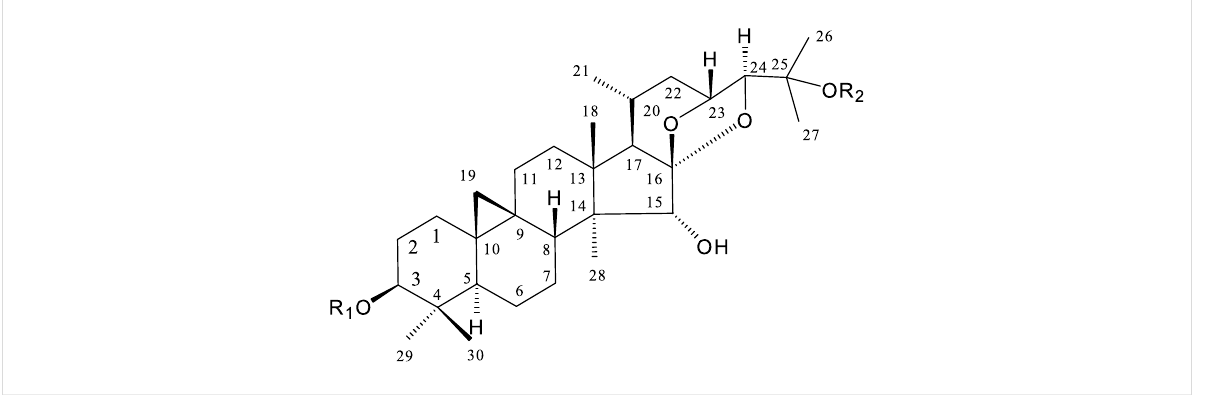
Figure 1: Compounds 1 and 2 isolated from Cimicifuga foetida . 1 . R 1 = 2'- O -acetylarabinosyl, R 2 = H; 2 . R 1 = 2'- O -acetylarabinosyl, R 2 = Ac